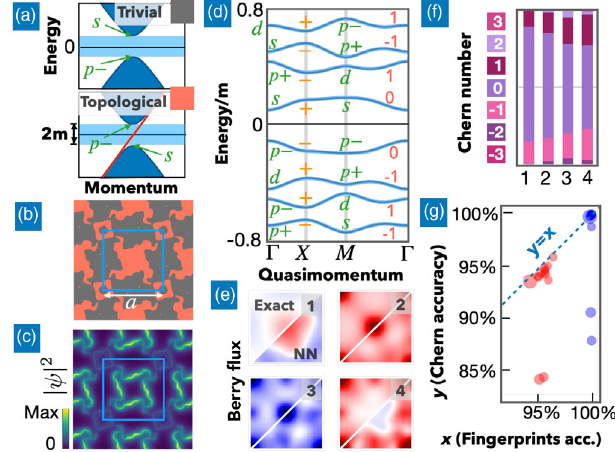
FIG. 5. Using the NN to investigate the spin Chern numbers in a family of 2D topological insulator metamaterials. (a) Sketch of the spin-polarized excitation spectrum in a semi-infinite-plane geometry for a trivial (top) and a topological (bottom) material 0 . The close to the Γ point, close to the Fermi energy E F ¼ topological material supports gapless edge states (red line). (b) Sketch of a metamaterial geometry. Its unit cell (blue) is subdivided into trivial (gray) and topological (red) domains according to a randomly drawn fourfold rotationally symmetric pattern. (c) Probability field for a metamaterial ’ s Bloch wave with energy within the single-domain band gap. (d) Metamaterial band structure. Shown are the first (last) four positive (negative) bands together with the symmetry labels and the Chern numbers (in red). Exact results and NN predictions are not distinguishable with bare eyes. (e) Exact and NN-predicted Berry fluxes for the first four bands. [(c) – (e) refer to the validation geometry shown in (b).] (f) Stacked bar chart of the Chern number distribution for the first four positive bands. (g) Scatter plot of the Chern and fingerprint accuracies for 13 trained NNs. Each NN is represented by a red and a blue circle. For the red circles, the rms band- structure deviation (radius of the circles), the fraction of correct fingerprints ( x coordinate), and Chern numbers ( y coordinate) are obtained, averaging over 2500 validation samples and the eight central bands. The blue circles take into account only bands separated from neighboring bands by a minimal splitting larger than 0 . 01 m